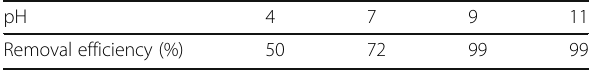
Table 3 Effect of pH solution on MB removal efficiency pH 4 7 9 11 Removal efficiency (%) 50 72 99